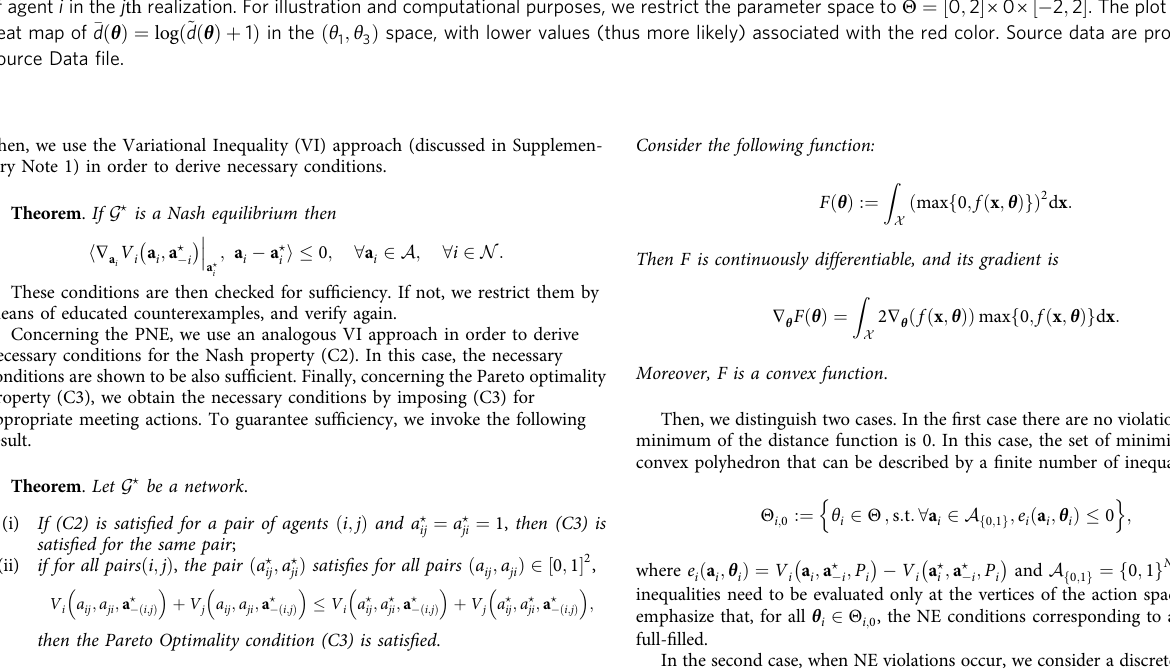
P P ~ d n N d j θ Þ , where d j θ Þ is the distance function ð θ Þ ¼ 1 nN i ¼ 1 j ¼ 1 i ð i ð